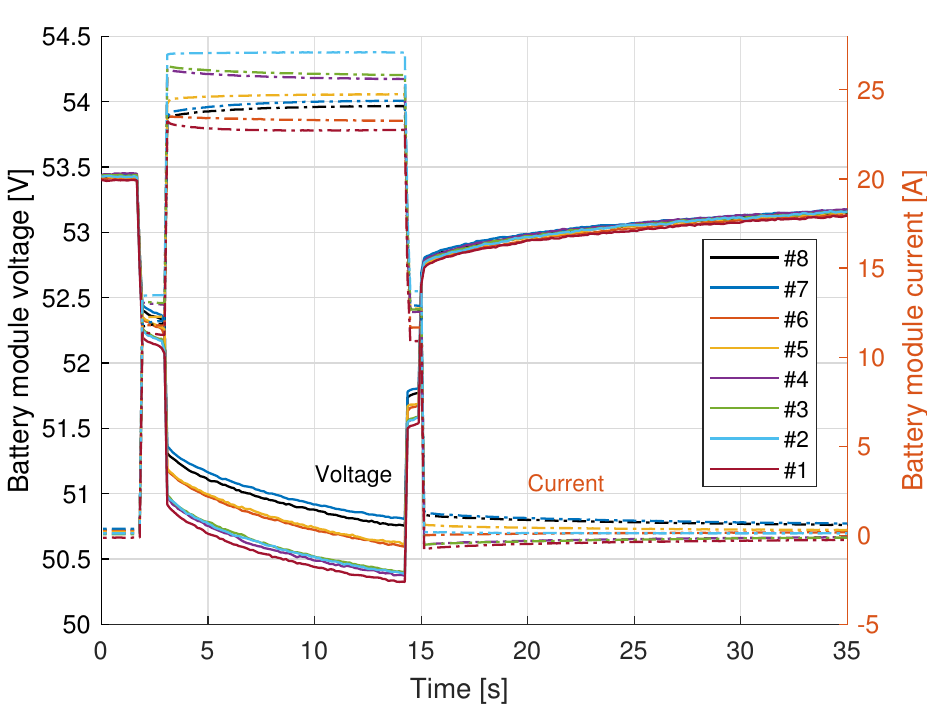
Figure 9. Discharging of battery pack in parallel configuration for about 10 s at 200A and following